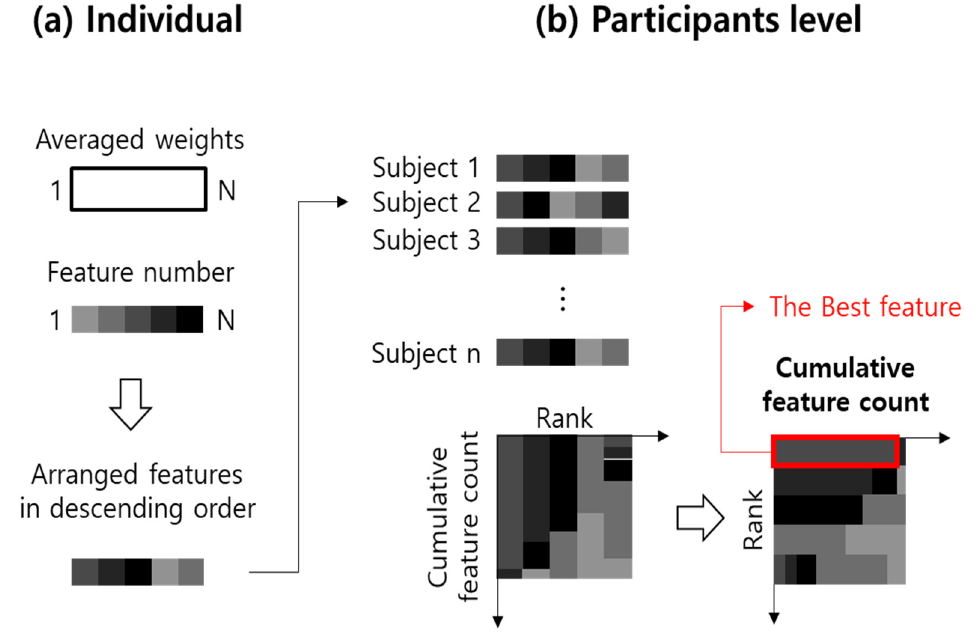
Figure 6. Visualization of the method for extracting the best feature. ( a ) Individual level, ( b ) Visualization of the method for extracting the best feature. Participants level.